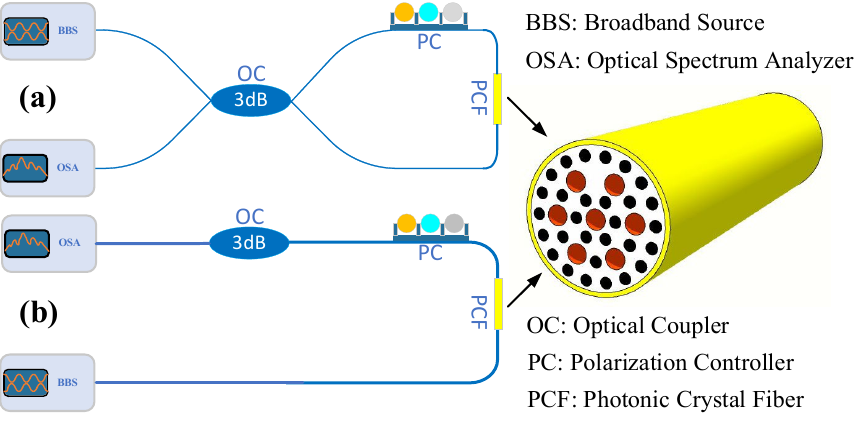
Figure 1. Schematic of the proposed sensor’s dual-parameter measurement. ( a ) Measurement of the transmission spectrum for the Sagnac interference. ( b ) Measurement of the loss spectrum for SPR.